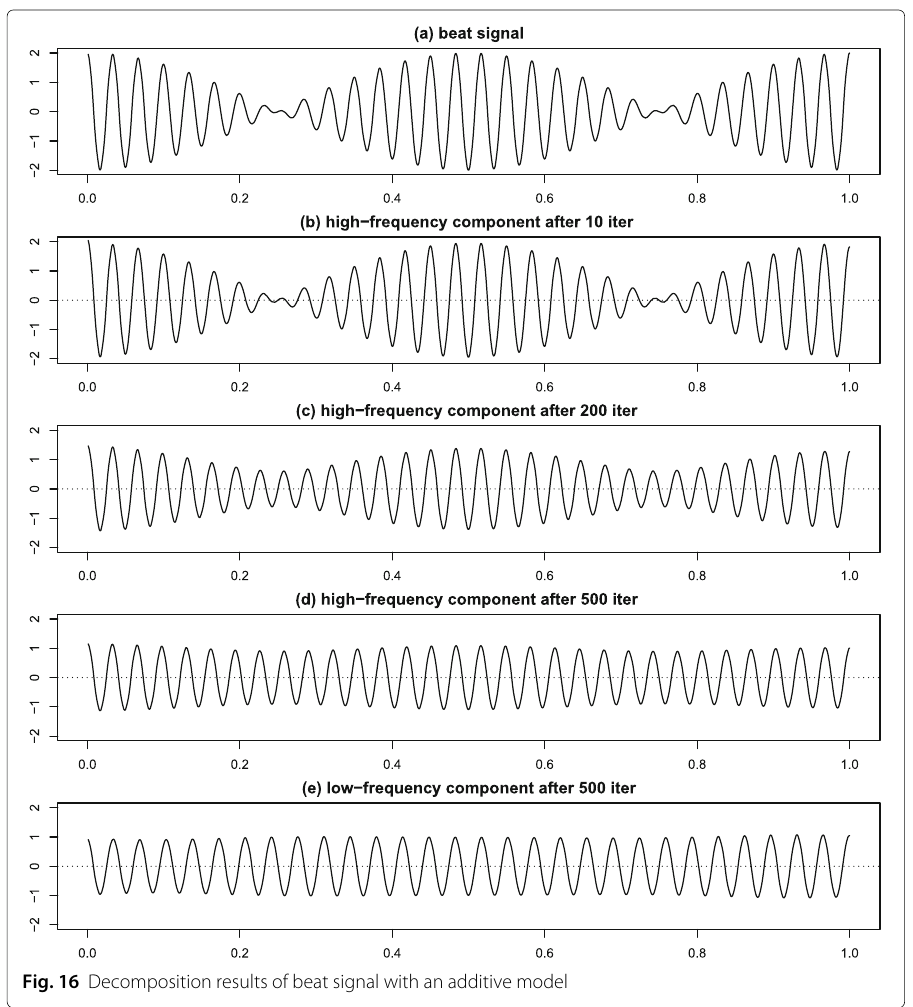
Fig. 16 Decomposition results of beat signal with an additive model